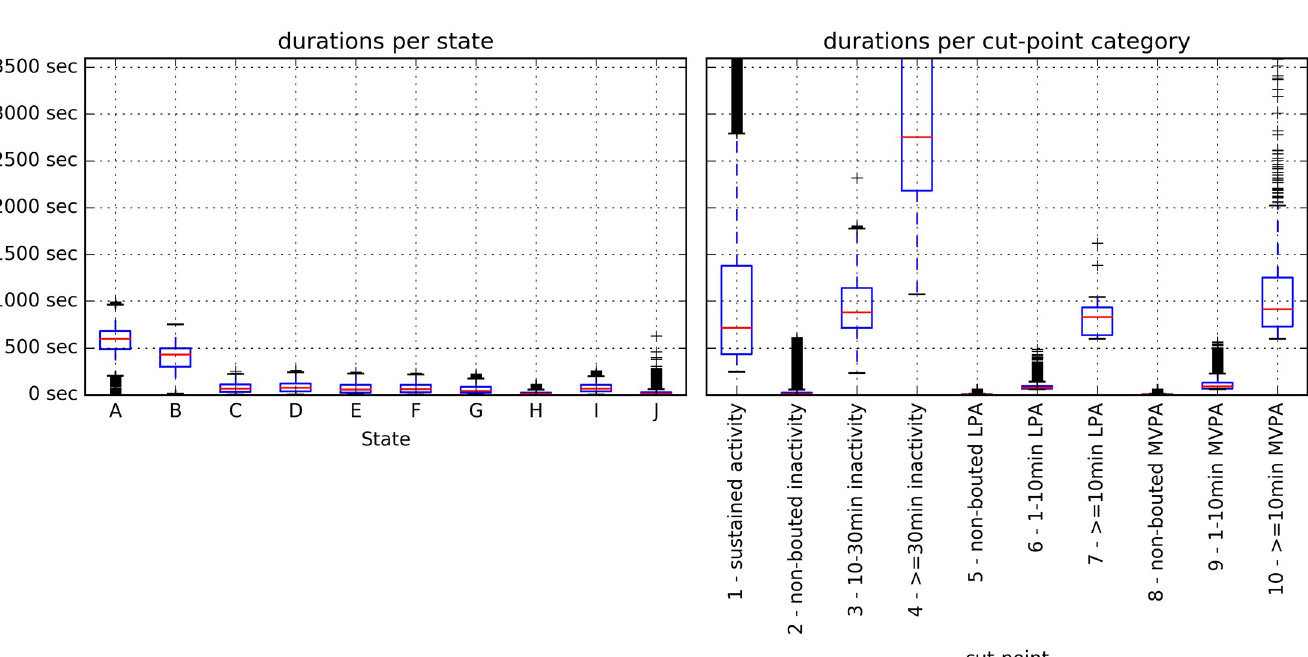
PLOS ONE | https://doi.org/10.1371/journal.pone.0208692 January 9,